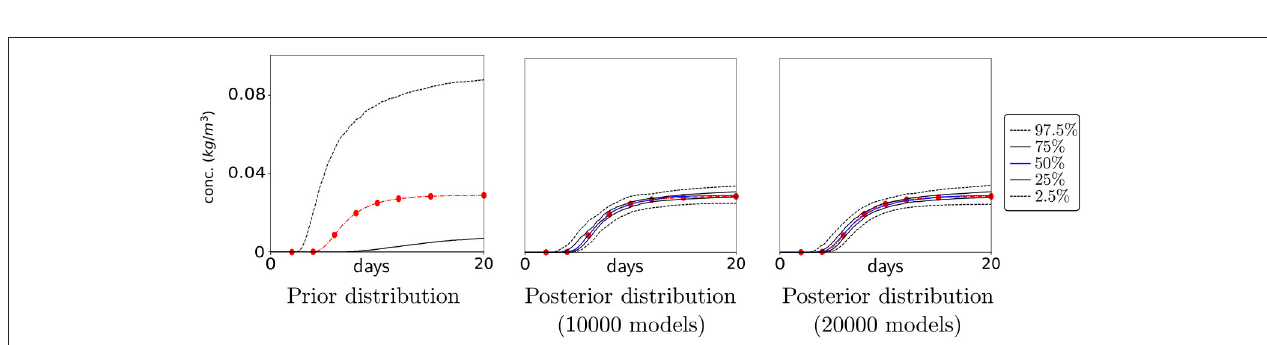
FIGURE 5 | Prior and posterior concentration probabilities at the pumping well. The curves indicate 2.5 − 97.5 % region (dashed), 25 − 75 % region (full) and average value (blue), while the red dots represent the reference concentration.